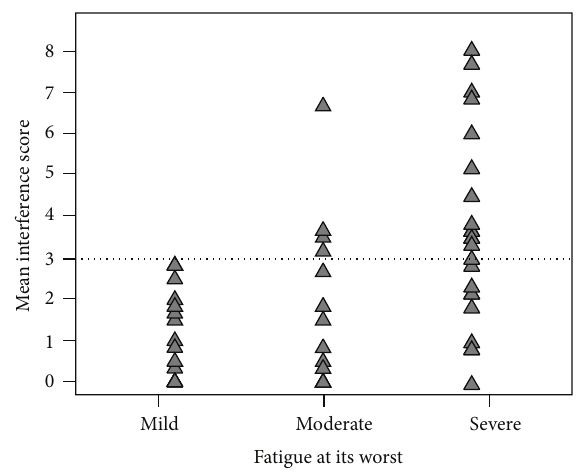
Figure 1: Interference of fatigue with mood and activity in patients categorized in mild, moderate, and severe fatigue intensity groups. Note: mean fatigue interference score = arithmetic mean of BFI items4–9;thedottedlineindicatesthecutoffformoderate-to-severe interference